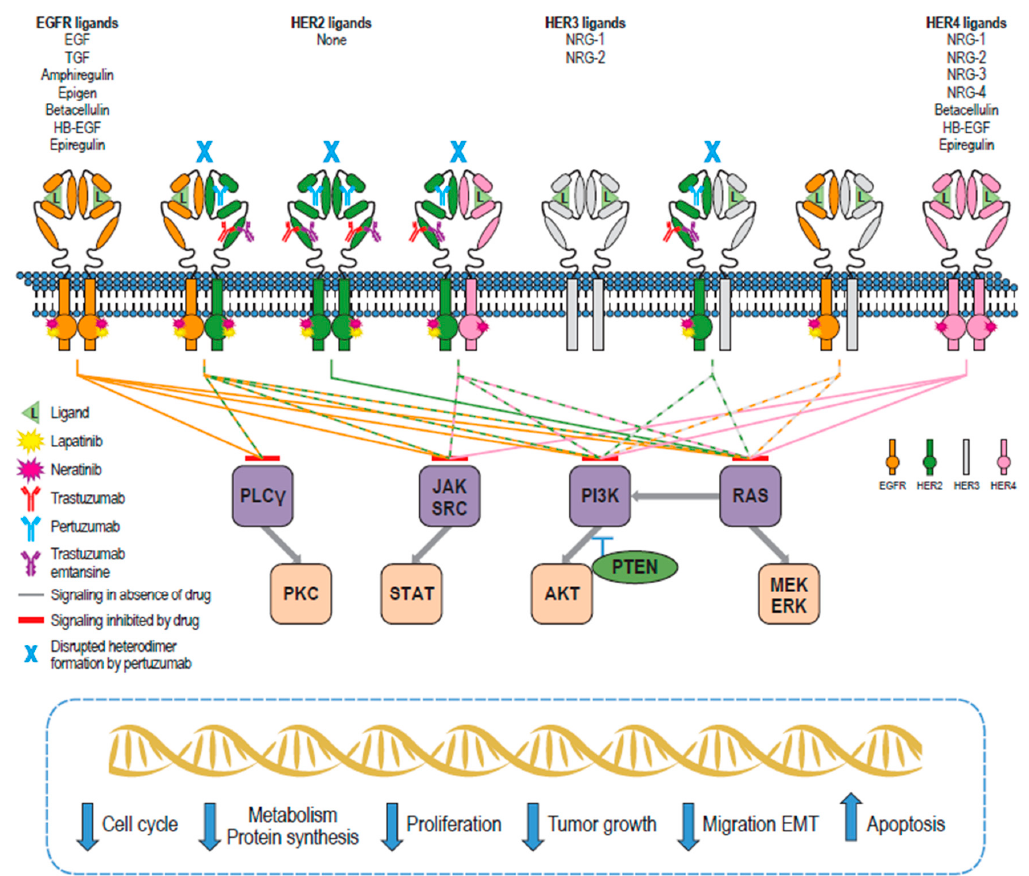
Figure 1. Schematic representation of members of the human epidermal growth factor receptor (HER) family, their natural ligands, interaction with the HER2-targeted therapies trastuzumab, pertuzumab, trastuzumab emtansine (T-DM1), lapatinib, and neratinib, and the downstream consequences of these interactions. Circles on EGFR, HER2, and HER4 represent the active kinase domain; the kinase domain on HER3 is inactive. Ligand binding initiates homo- or heterodimerization of HER family members, leading to intracellular signaling cascades that are dependent on the dimers formed (e.g., PI3K / AKT and MAPK [Ras / MEK / extracellular signal-regulated kinase (ERK)]). HER-family signaling a ff ects multiple cell processes including cell cycle, metabolism / protein synthesis, proliferation, migration, epithelial–mesenchymal transition (EMT), and apoptosis. Trastuzumab inhibits HER2 signaling and can engage in antibody-dependent cell-mediated cytotoxicity (ADCC). Pertuzumab can also mediate ADCC and inhibits HER2 dimer formation, abrogating HER2 intracellular signaling. The trastuzumab-based antibody–drug conjugate T-DM1 maintains the functions of trastuzumab but also delivers a cytotoxic payload (emtansine) on internalization of the receptor / T-DM1 complex. Lapatinib and neratinib are small-molecule tyrosine kinase inhibitors targeting the cytoplasmic ATPase domain of HER family members. This figure is adapted from publications by Roskoski et al. [15], Segovia-Mendoza et al. [24], Kourie et al. [25], Appert-Collin et al. [26] and references cited therein; further detail can be found within those publications. Signaling pathway interactions adapted from the KEGG pathway database. AKT, protein kinase B; EGF, epidermal growth factor; EGFR, epidermal growth factor receptor; ERK,